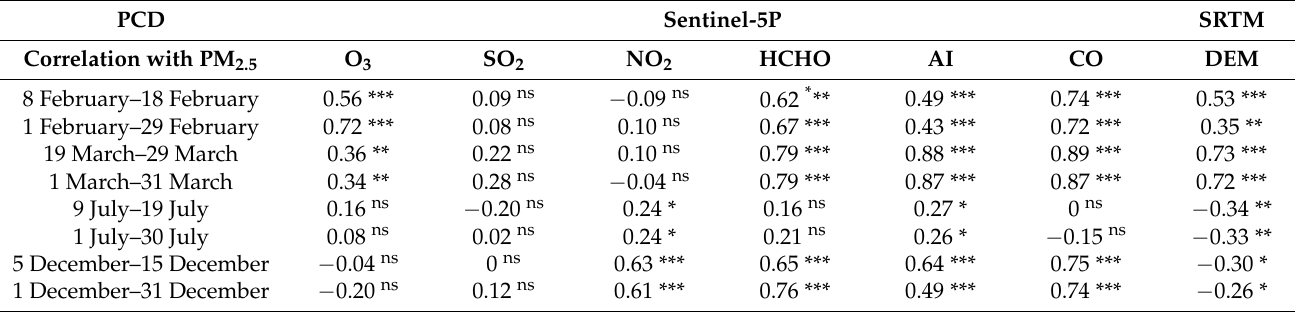
Table 2. Pearson correlation coefficients and associated p -values for assessing the correlation of variables with PM 2.5 in respective